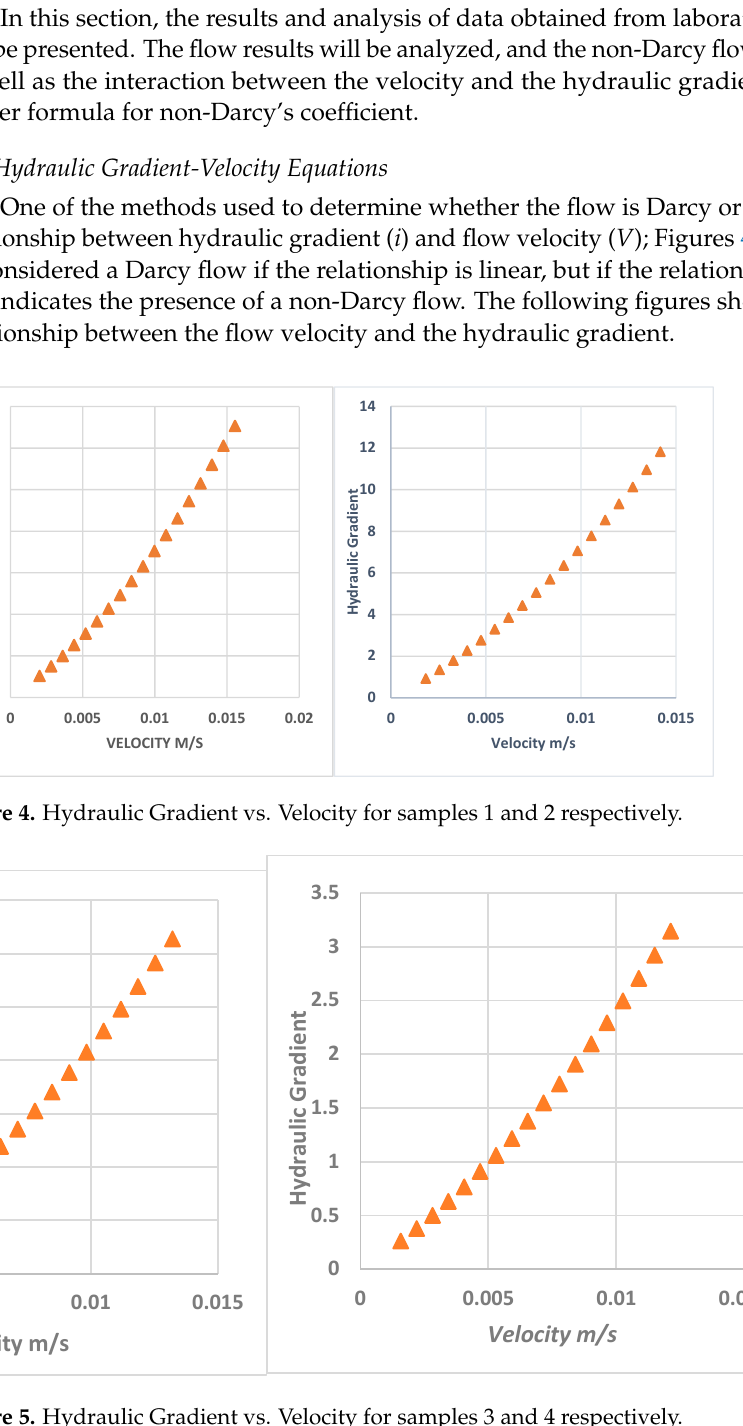
Figure 5. Hydraulic Gradient vs. Velocity for samples 3 and 4 respectively.